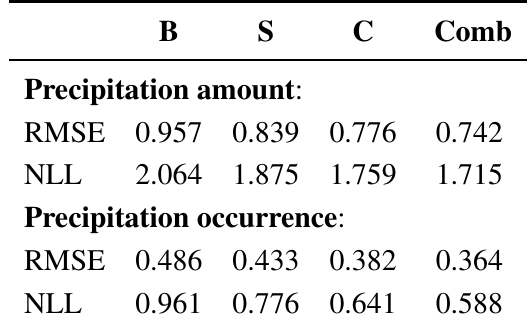
Table 1. Skill measures for probabilistic daily precipitation estimates relative to APHRODITE values averaged over Nepal and vicinity, 2001–2007. The models are B = baseline (same probability distribution for all locations and days), S =